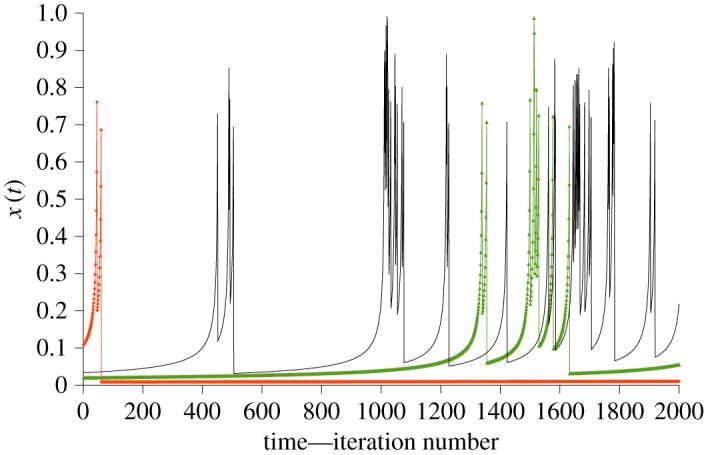
Three typical time trajectories of the Pomeau–Manneville map with initial conditions close to zero and parameters as described in the text. Repeated simulation suggests that no run ‘takes off’ before about 40 iterations.